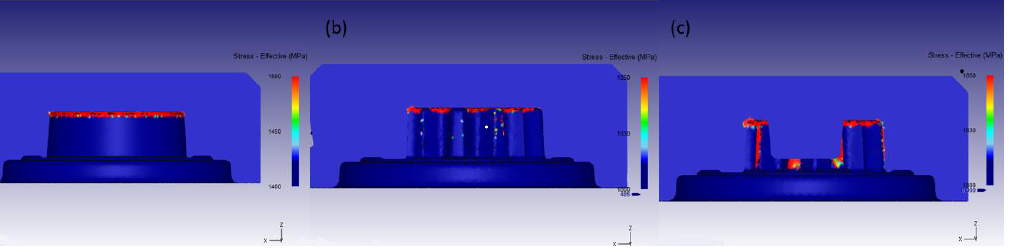
Figure 22. Comparison of effective stress in MPa (with lateral view): ( a ) Actual top die, ( b ) Top die with teeth, ( c ) Top die with punch. Figure 21. Comparison of effective stress in MPa: ( a ) Actual top die, ( b ) Top die with teeth, ( c ) Top die with punch.